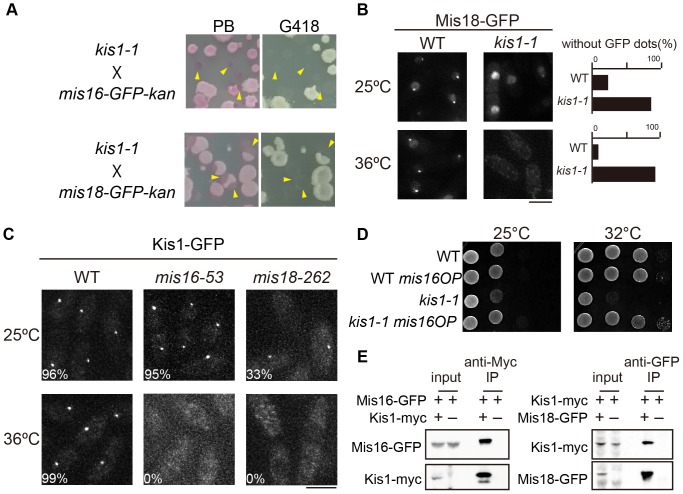
Genetic and physical interaction between Kis1/Mis19 and the Mis16-Mis18 complex.(A) Genetic crossing of kis1-1 and the mis16-GFP-kan or mis18-GFP-kan mutant was performed, and spores were germinated on YE5S plates at 25°C. Colonies were then replica-plated onto YE5S plates with phloxine B (PB) or with kanamycin (G418) and incubated at 36°C or 25°C, respectively. The temperature-sensitive colonies (arrowheads) were sensitive to G418 without exception, indicating that the double mutant was inviable. mis16 and mis18 were found on the chromosome III, whereas kis1/mis19 was on chromosome II, excluding the possibility of genetic linkage between kis1/mis19 and mis16/mis18. (B) WT or kis1-1 cells expressing Mis18-GFP from plasmids were observed after growth at 25 or 36°C for 6 h. Percentages of cells without Mis18-GFP dots are shown (n≥100). (C) Localization of Kis1-GFP in WT, mis16-53, or mis18-262 cells grown at 25 or 36°C for 6 h. Frequencies are also given (n≥100). Scale bars, 5 µm. (D) Overexpression of Mis16-GFP suppressed the temperature sensitivity of kis1-1. Cells harboring plasmid pREP1-mis16-GFP (mis16 OP) were spotted on EMM plates and incubated at 25 or 32°C. Cells harboring pREP1-GFP were spotted as controls. (E) Coimmunoprecipitation (IP) of Kis1 and the Mis16–Mis18 complex. Cell extracts (input) were prepared from cells expressing (+) or not expressing (−) the indicated proteins. Kis1-myc (left) and Mis18-GFP (right) were immunoprecipitated with anti-Myc or anti-GFP, respectively. IP samples as well as 2.5% of the input were analyzed.